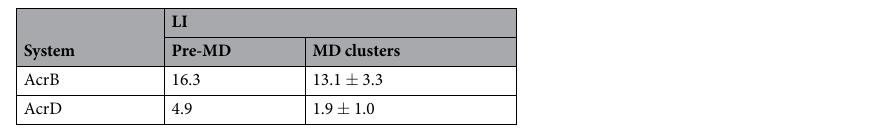
Table 4. Lipophilic indexes of DP in the Tight protomer of AcrB and AcrD. See Table 3 for further